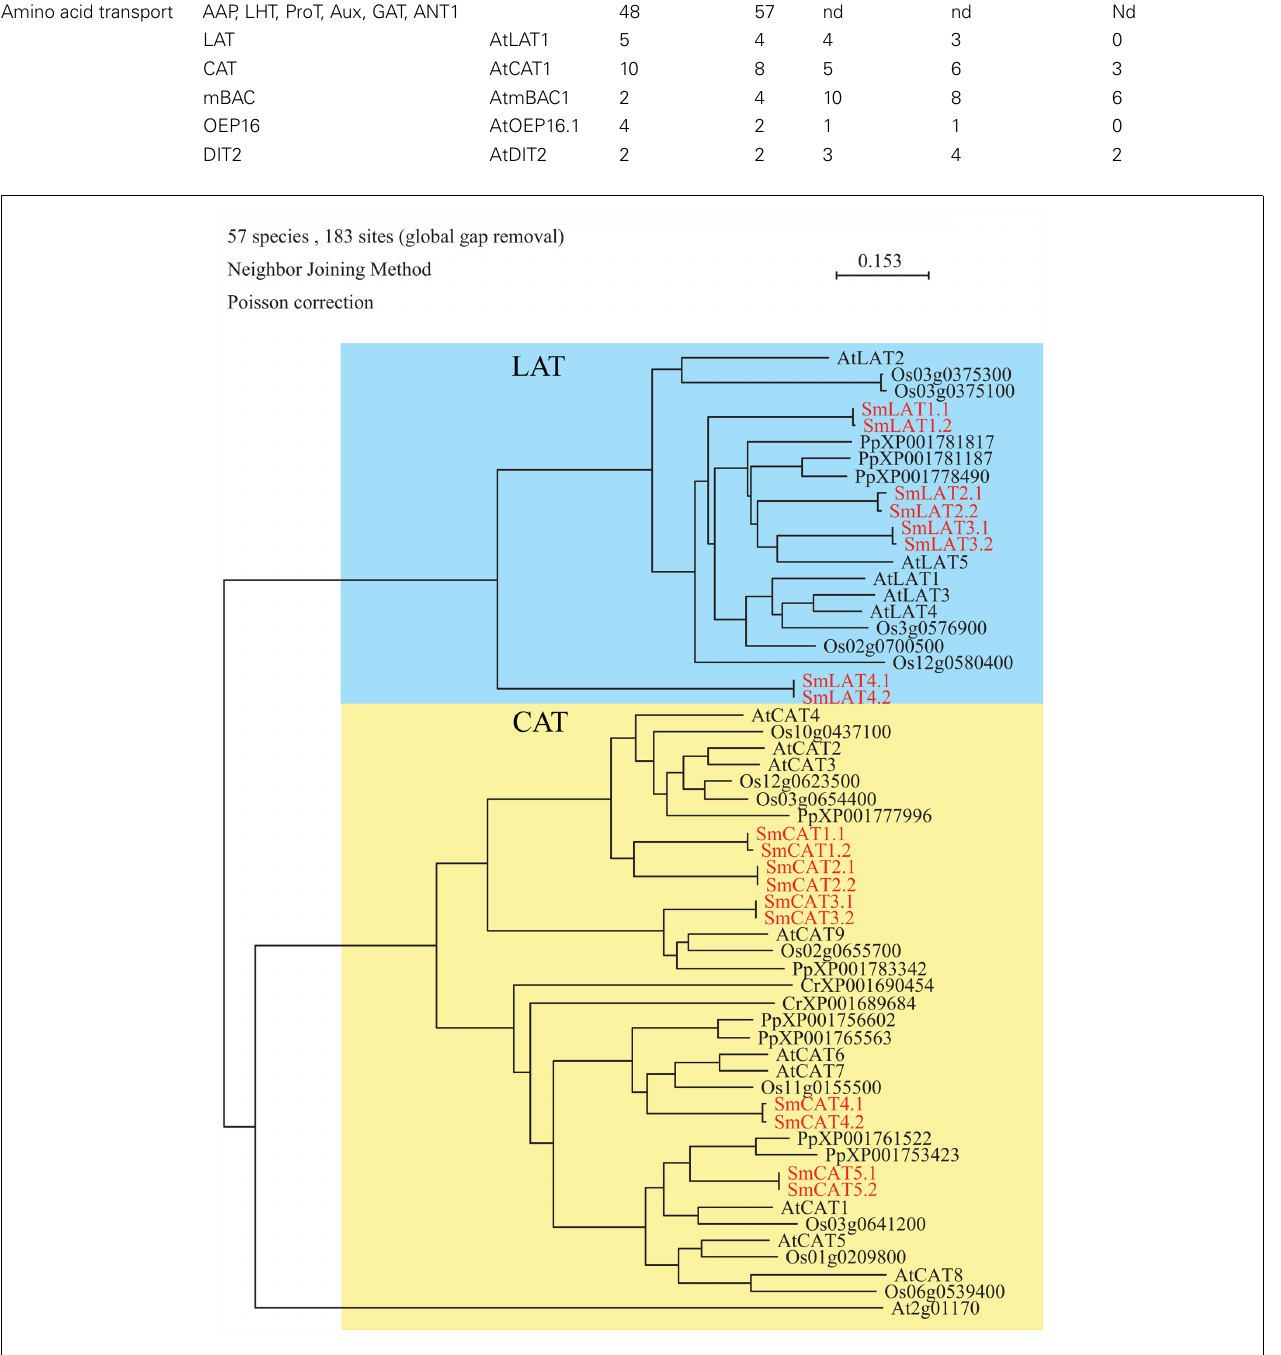
Chlamydomonas reinhardtii ; Os, Oryza sativa ; Pp, Physcomitrella patens ; Sm, Selaginella moellendorffii. Red letters indicate a Selaginella moellendorffii